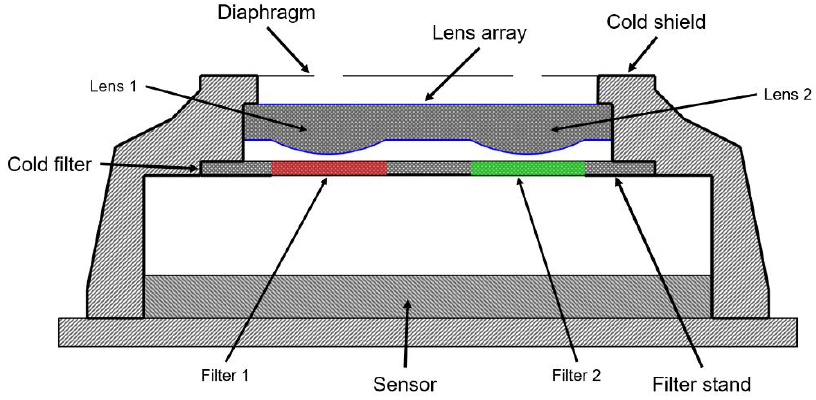
Figure 1. Cross-section of the ONERA multispectral camera. The diaphragm, the lens array, the filter array and the sensor are shown from top to bottom.